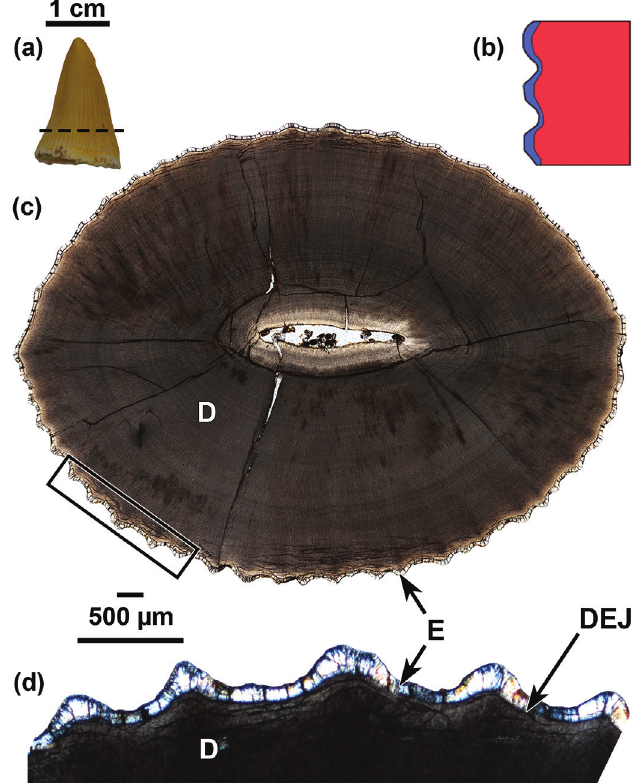
Figure 2. Anatomy of a faceted Mosasaurus sp. tooth (UALVP 57353). A, tooth in labial view with approximate plane of section indicated by the dashed line; B, schematic diagram illustrating the relationship between the enamel (blue) and the dentine (red); C, transverse section seen under plane polarized light. Box indicates the region magnified in (D). D, close-up of the dentine-enamel junction viewed under crossed polarized light. Abbreviations: D, dentine; DEJ, dentine-enamel junction; E, enamel.